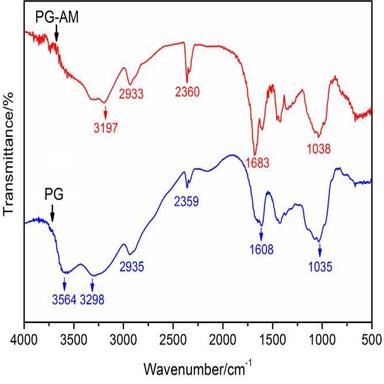
FT-IR spectra of PG polysaccharide and PG-AM grafted copolymer.